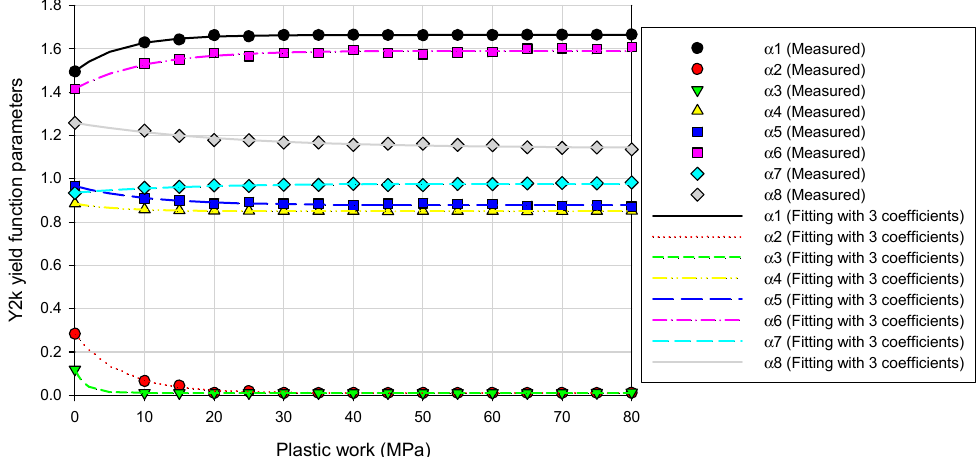
Figure 8. Evolutions of the parameters of the yield function (Yld2000-2d function) for the Q&P 980 steel with respect to the plastic work. Table 5. Evolution coefficients for the parameters of the yield function of the Q&P 980 steel.